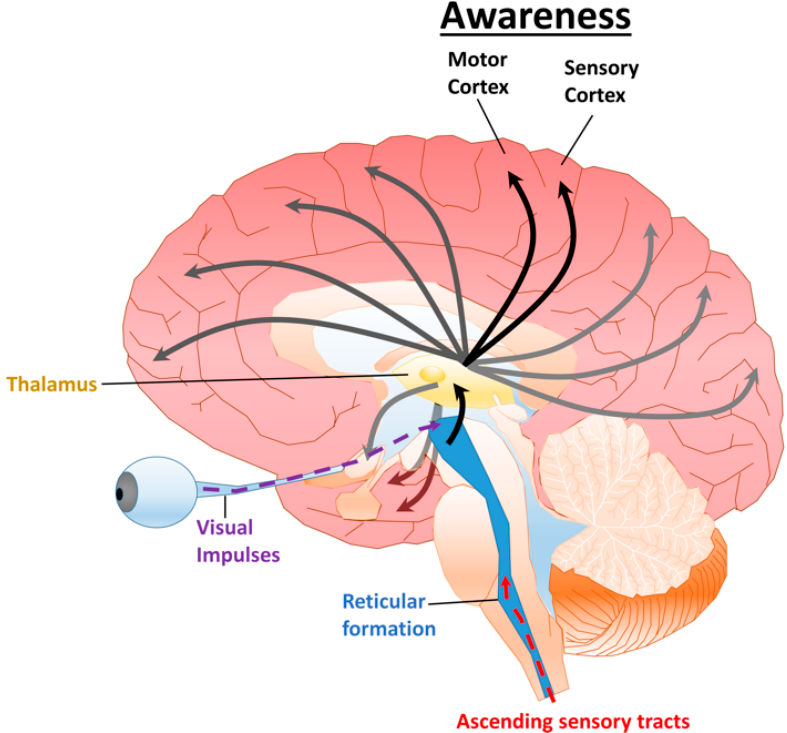
Figure 1. Diagram of the ARAS and cortical projections. The ARAS is composed of a network of neurons connecting the reticular formation, hypothalamus, and thalamus, which have widespread projections to various cortical regions. A variety of stimuli including visual and somatosensory (pain, touch, and temperature) excite the reticular activating system, generating arousal. Projec- tions to the sensory and motor cortex are requisite for awareness. Additional connections to the cortex, amygdala, and hippocampus contribute to frontoparietal cortex, amygdala, and hippocampus contribute to attention.